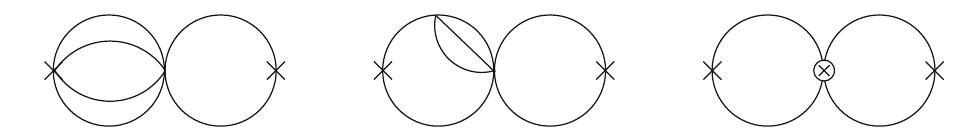
Fig. 7 Leading contributions to the (cid:2) TT (cid:3) from the (cid:2) 6 interaction 3 − (cid:19) , one